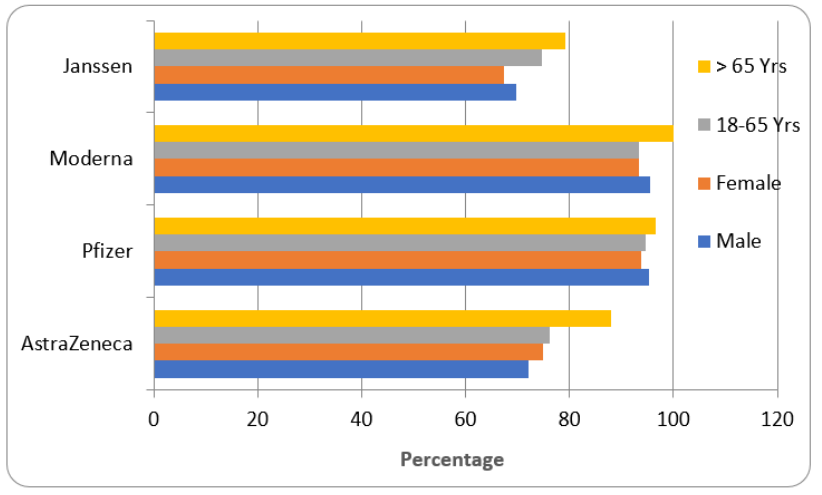
Figure 5. Efficacy of COVID-19 vaccine.